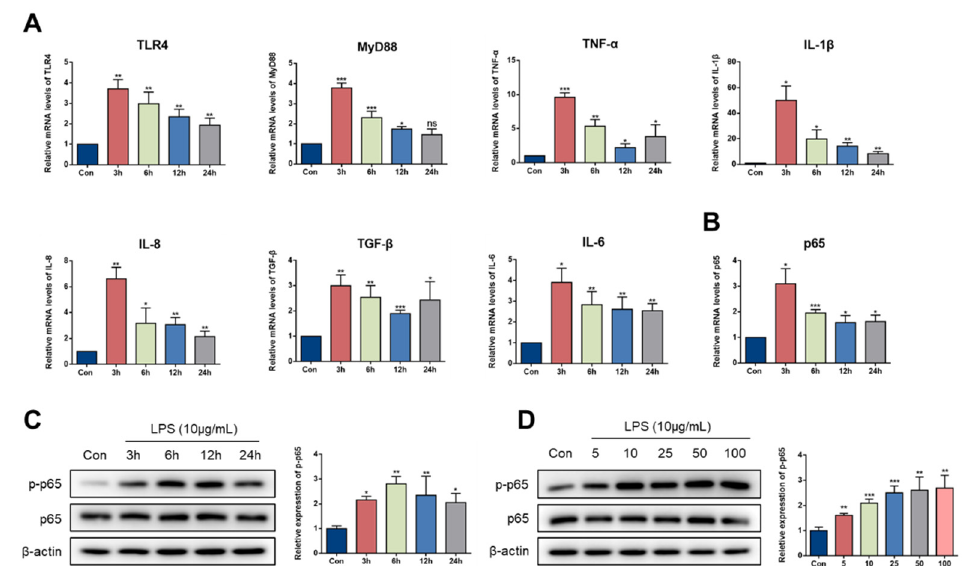
Figure A3. LPS induced inflammation responses in GMECs. ( A ) mRNA expression levels of the TLR4 signaling pathway and transcription of inflammatory cytokines after treatment of 10 µ g/mL LPS. ( B ) mRNA level of p65 was upregulated by 10 µ g/mL LPS. ( C ) p-p65 expression after LPS treatment with different time gradients. (original western blot figures in Figure S12). ( D ) p-p65 expression after 6 h of LPS treatment with different concentration gradients. (original western blot figures in Figure S13). * Indicates a significant difference compared with the control group, * p < 0.05, ** p < 0.01, *** p < 0.001.